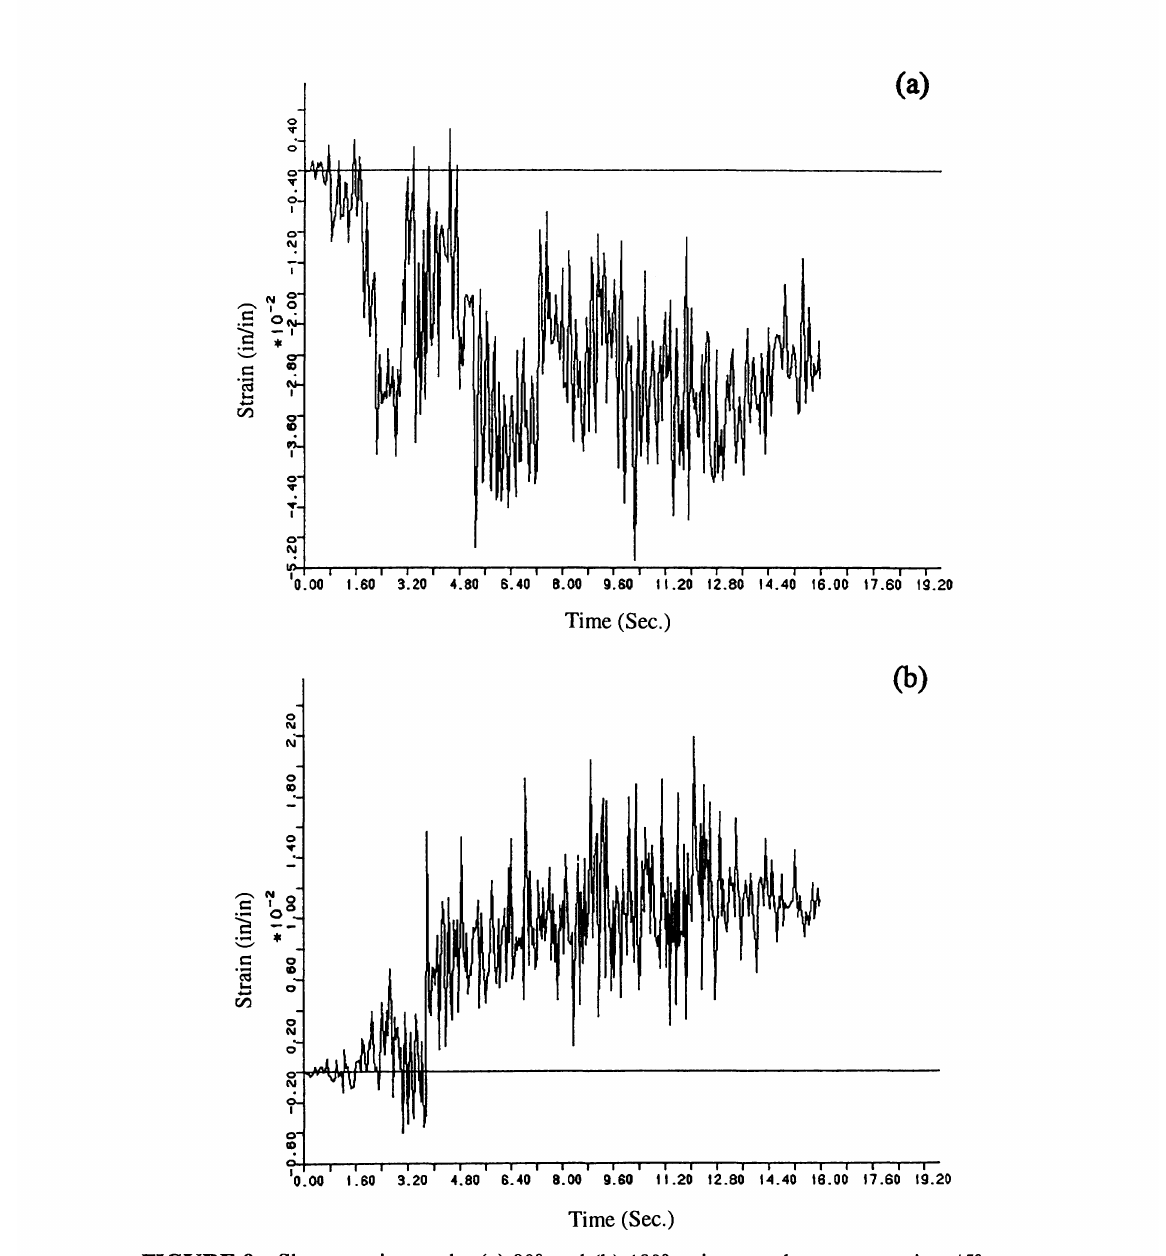
FIGURE 9 Shear strains at the (a) 90° and (b) 180° points on the cross section 45° away from the elbow end under actual cyclic